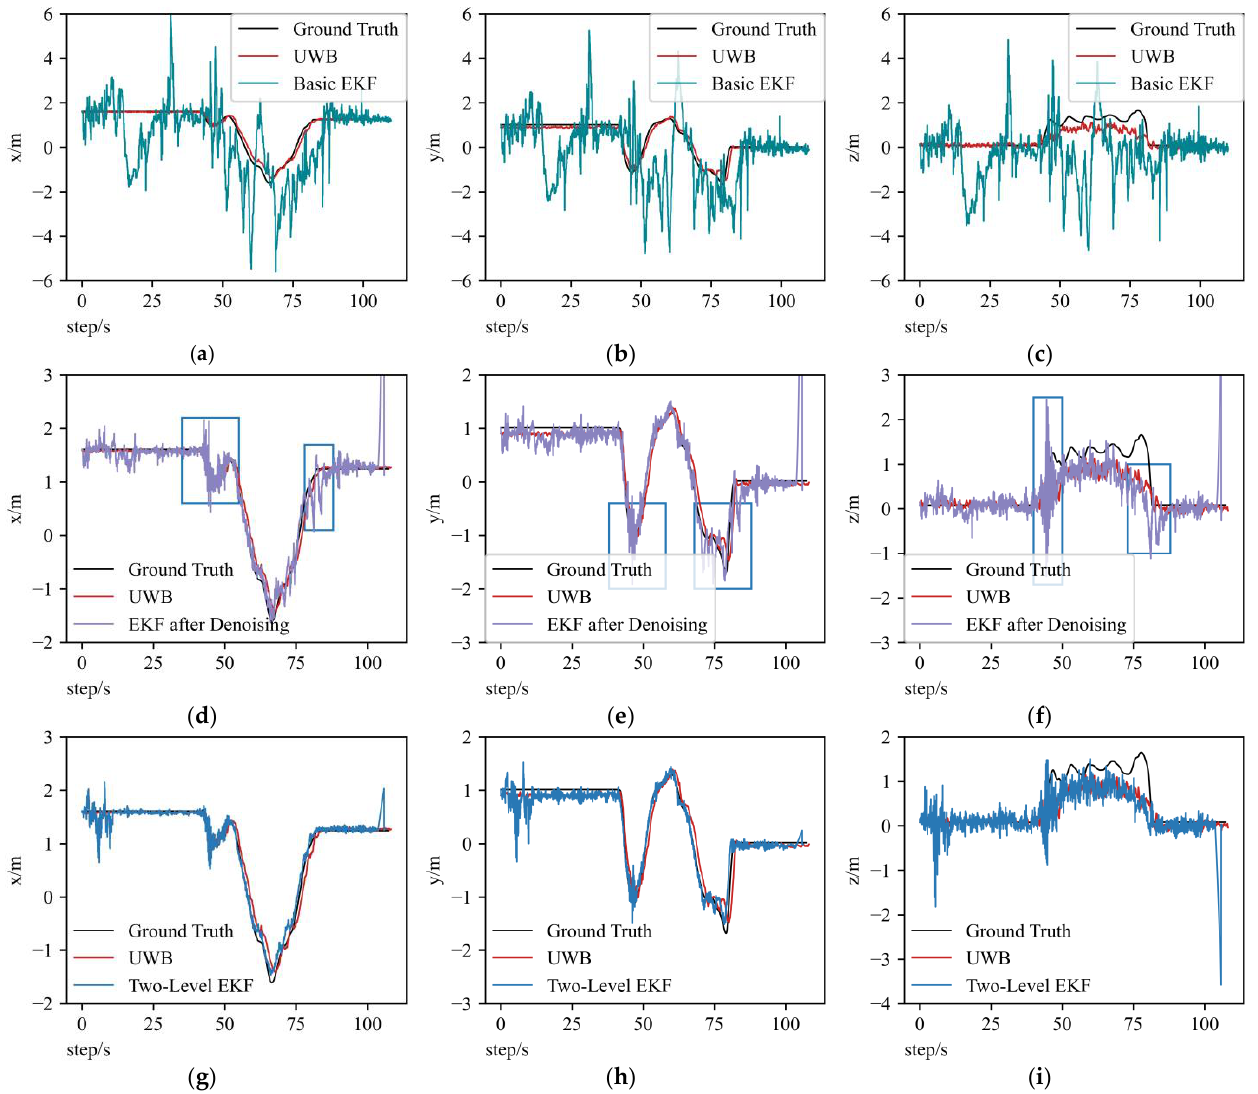
Figure 7. Trajectory plots of three methods (two-level error model EKF method, basic EKF method and EKF method with data after denoising) in x, y and z axes. ( g – i ) are trajectory estimation comparisons of two-level EKF, UWB and ground truth by Mocap. ( a – c ) are trajectory estimation comparisons of basic EKF method, UWB and ground truth. ( d – f ) are trajectory comparisons of EKF based on data after denoising, UWB and ground truth.